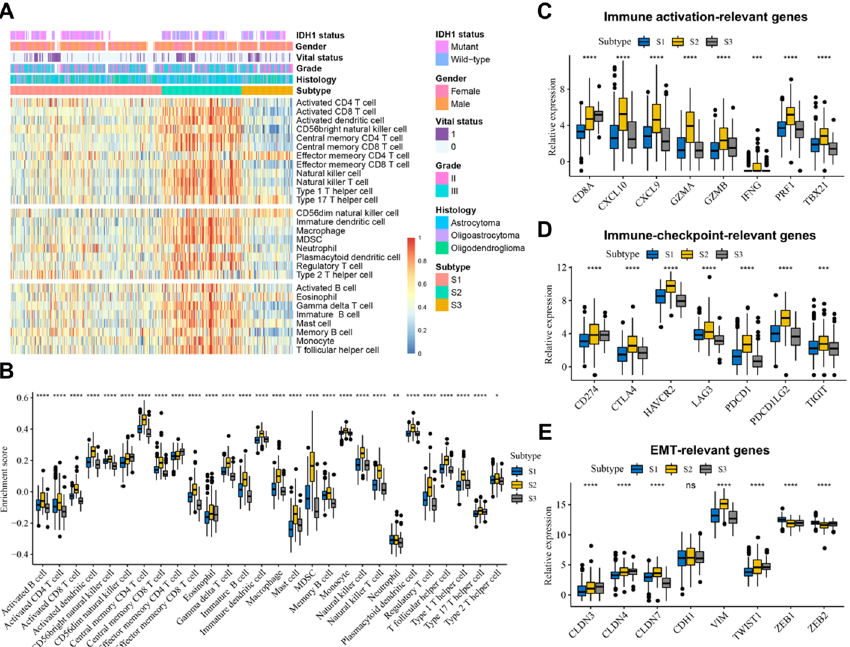
Fig. 6 Immune-related features of RRG-related subtypes. a Heatmap of the relationship between RRG-related subtypes and 28 immune cell subpopulations identified by a previous study. IDH1 status, Gender, vital status, histologic subtype, grade and RRG-related subtypes are shown as patient annotations. b boxplots of the relationship between RRG-related subtypes and 28 immune cell subpopulations. The upper and lower ends of the boxes represented interquartile range of values. The lines in the boxes represented median value, and black dots showed outliers. c Immune activation-relevant genes (CD8A, CXCL10, CXCL9, GZMA, GZMB, IFNG, PRF1, and TBX21) expressed in three RRG-related subtypes. d Immune-checkpoint-relevant genes (CD274, CTLA4, HAVCR2, LAG3, PDCD1, PDCD1LG2, and TIGIT) expressed in three RRG-related subtypes. e EMT-relevant genes (CLDN3, CLDN7, CLDN4, CDH1, VIM, TWIST1, ZEB1, and ZEB2) expressed in three RRG-related subtypes. Within each subtype, the upper and lower ends of the boxes represented interquartile range of values. * P < 0.05, ** P < 0.01, *** P < 0.001, **** P <